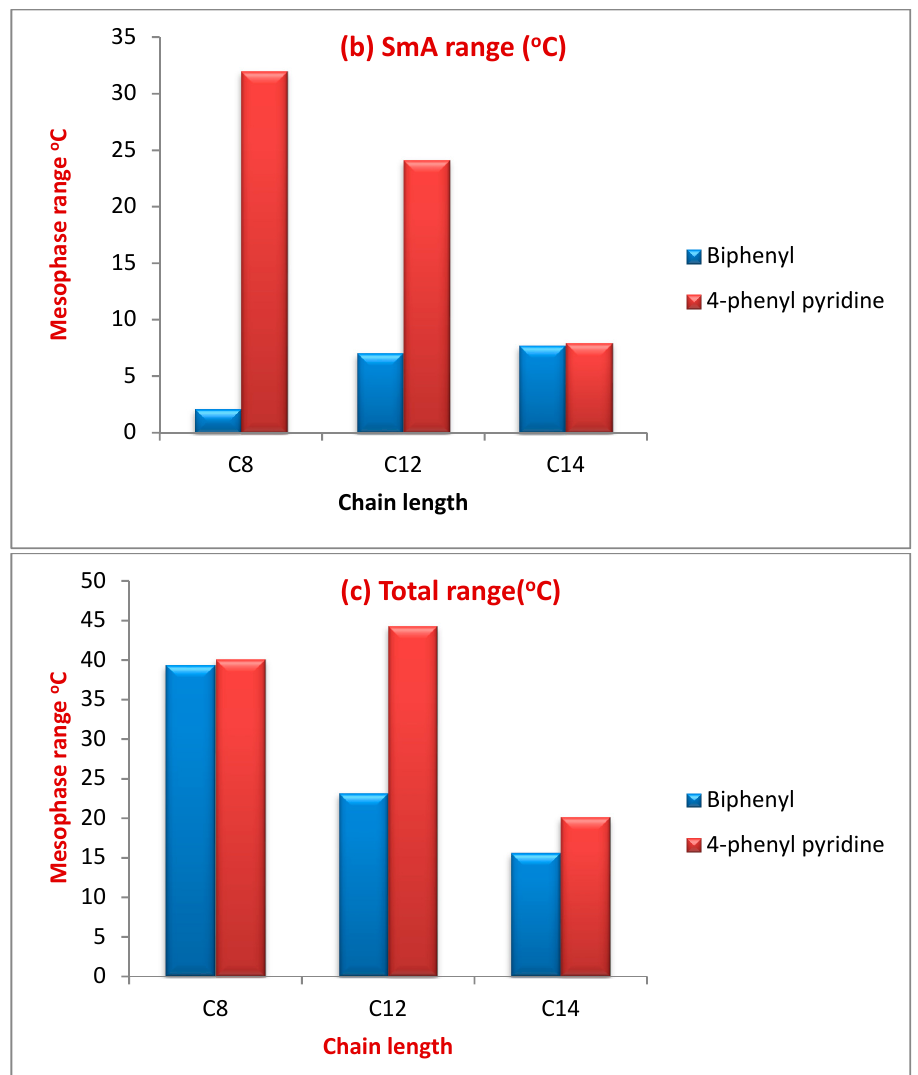
Figure 3. Effect of the alkyl chain length on mesophase behaviour of the biphenyl and 4-phenyl pyridine-based mesogens. ( a ) Dependence of smectic X1 range on terminal alkyl chain length. ( b ) Graphical representation of dependence of smectic A range on the terminal chain length. ( c ) Graphical representation of dependence of total mesomorphic range on the terminal chain length. SmX1 and SmA were identified by the authors in [40] for samples 3.c , 3.d and 3.e (referred to as Biphenyl in this figure) as SmX1 and SmA, respectively.